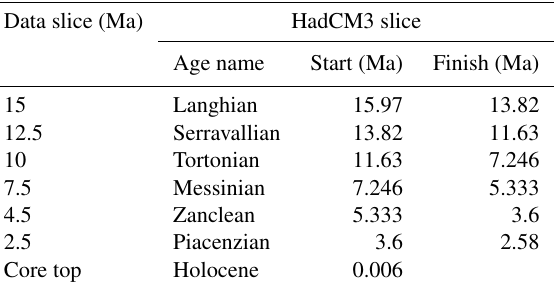
Table 1. Data slices for the approximate carbon cycling loca- tions (in time), and the HadCM3L set-ups used to create cGENIE bathymetry. The 7.5 and 2.5Ma time slices are just outside the ages to which they are assigned; however, in order to not have two points in the other ages, they are placed in the Messinian and Piacenzian